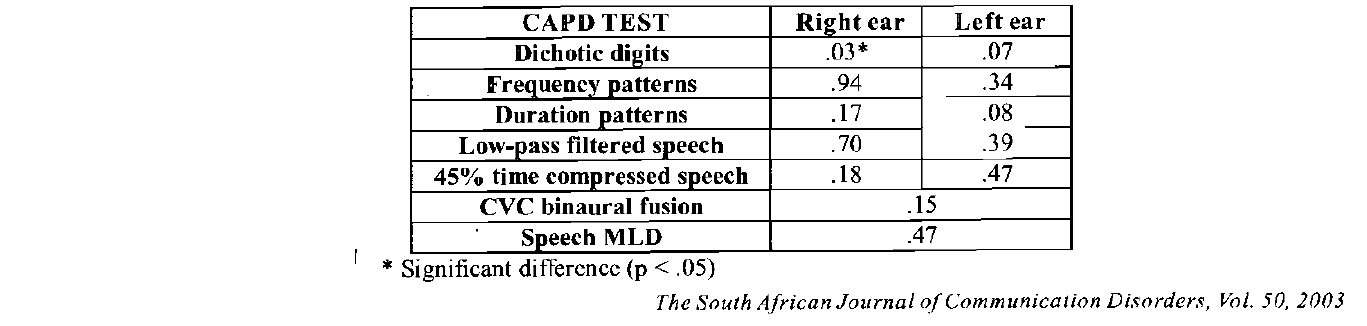
Table 2. Mann-Whitney U test results (p values) for comparisons in CAPD test performances between SA English first (n=16) and second (n=16) language